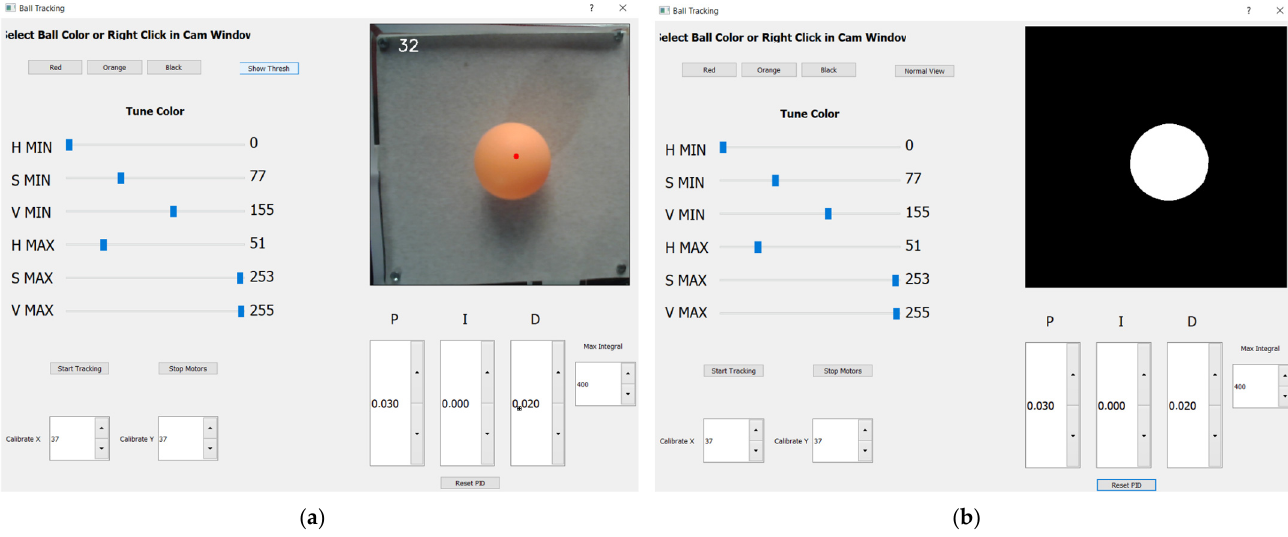
Figure 15. “Ball Tracking” pop-up window: ( a ) “Normal View” shows actual camera live stream image; ( b ) “Show Thresh” shows binary image (white ball contour on the black plate). Six HSV palette sliders are located on the left side of the Ball Tracking pop-up